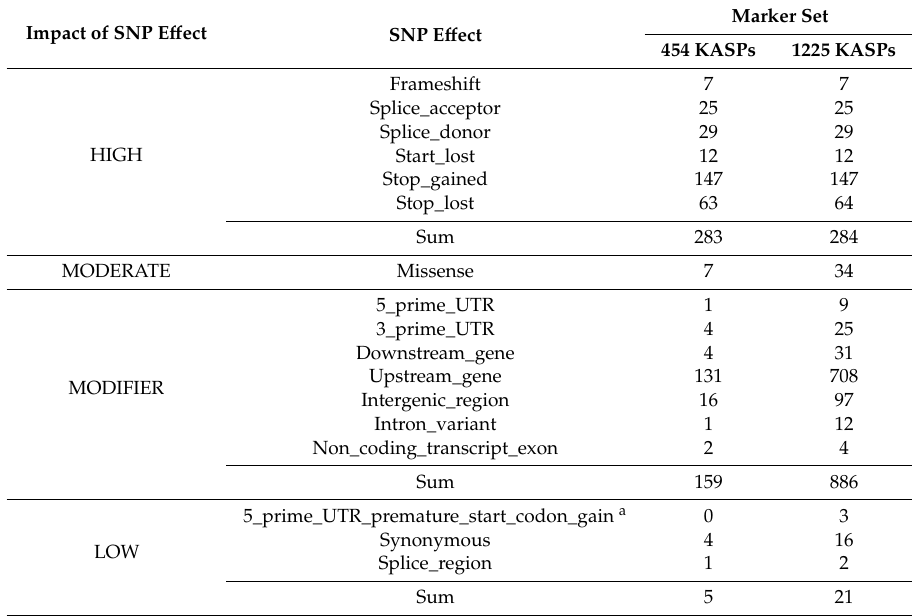
Table 3. Classification of KASP markers by their SNP e ff ects.